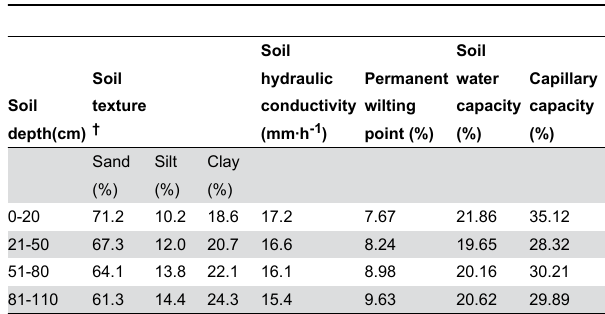
Table 1. Soil basic properties of the different layers at the study area.